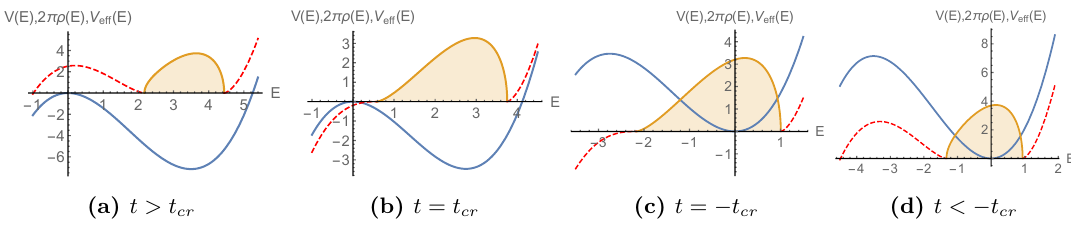
Figure 22. The potential V ( E ) (blue), (rescaled) spectral density 2 πρ ( E ) (shaded yellow), and effective potential V eff ( E ) (dashed red) in the one-cut case for different t